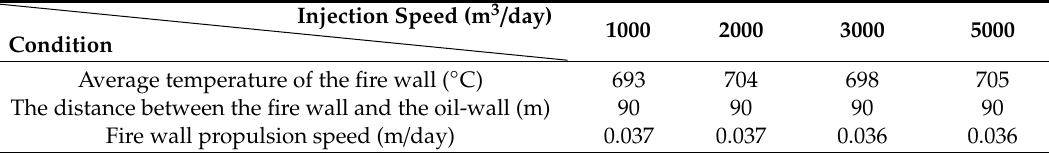
Table 7. Characteristic parameters of di ff erent air injection velocity fire wall.